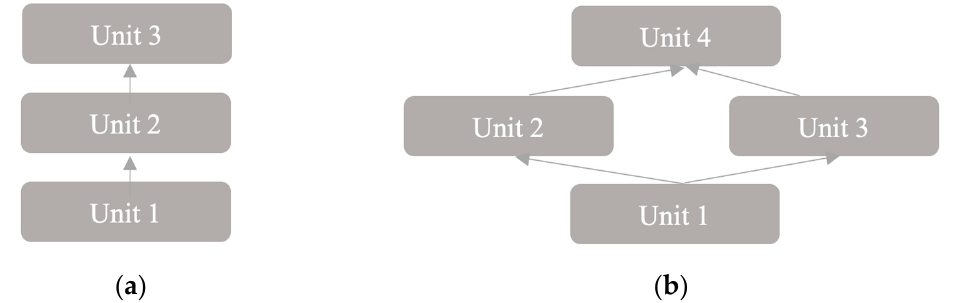
Figure 1. The difference between fully ( a ) and sparsely ( b ) connected architectures.